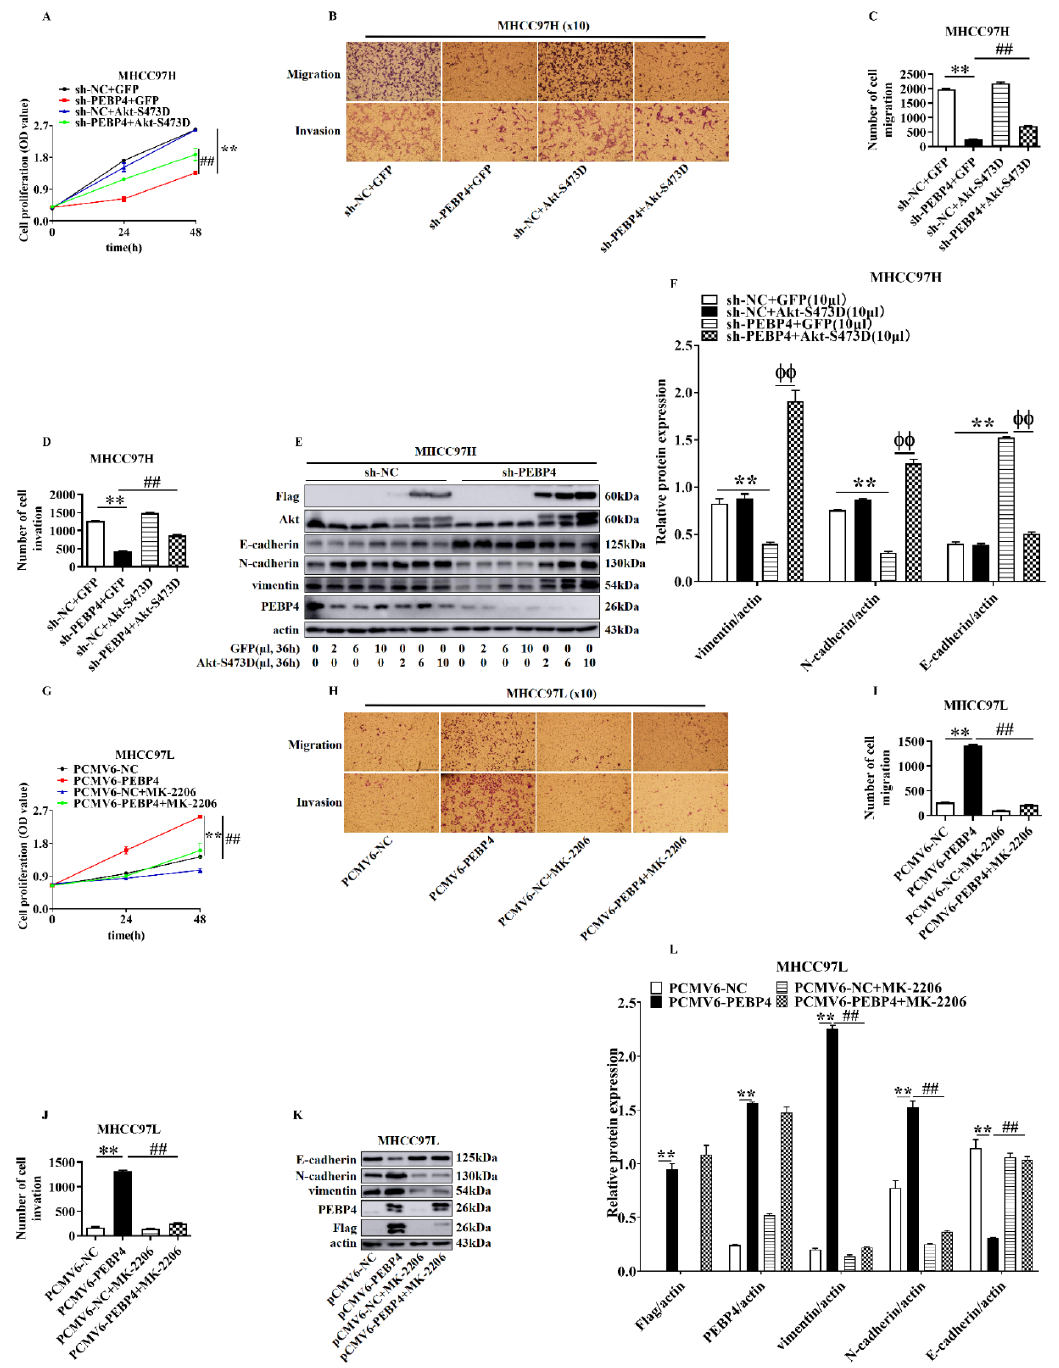
Figure 6. The role of Akt in mediating the effect of PEBP4 on proliferation, migration, invasion, and EMT markers of HCC. ( A – D ) MHCC97H cells containing sh-PEBP4 or sh-NC were infected with adenovirus expressing Akt S473D or GFP. Cell proliferation ( A ), migration and invasion were assayed ( B ) and quantified ( C , D ). ( E , F ) EMT markers were examined by Western blot € and WB bands semi-quantified as opposed to actin ( F ). ( G – L ) MHCC97L cells transfected with pCMV6-PEBP4 or the empty vector pCMV6-NC were treated with MK2206 or DMSO, cell proliferation ( G ), cell migration, and invasion were examined ( H ) and quantified ( I , J ). EMT markers were examined by WB ( K ) and bands were quantified against actin ( L ). All experiments were repeated three times. Data were presented as mean ± SEM (n = 3), ** p < 0.01, ## p < 0.01, φφ p <